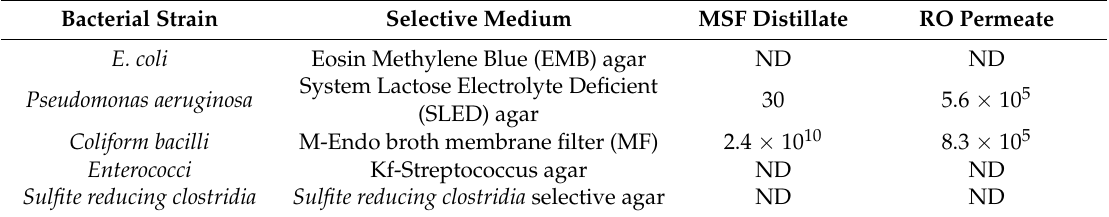
Table 2. Results of bacteriological analyses of the MSF and RO water samples (CFU/100 mL) a . Bacterial